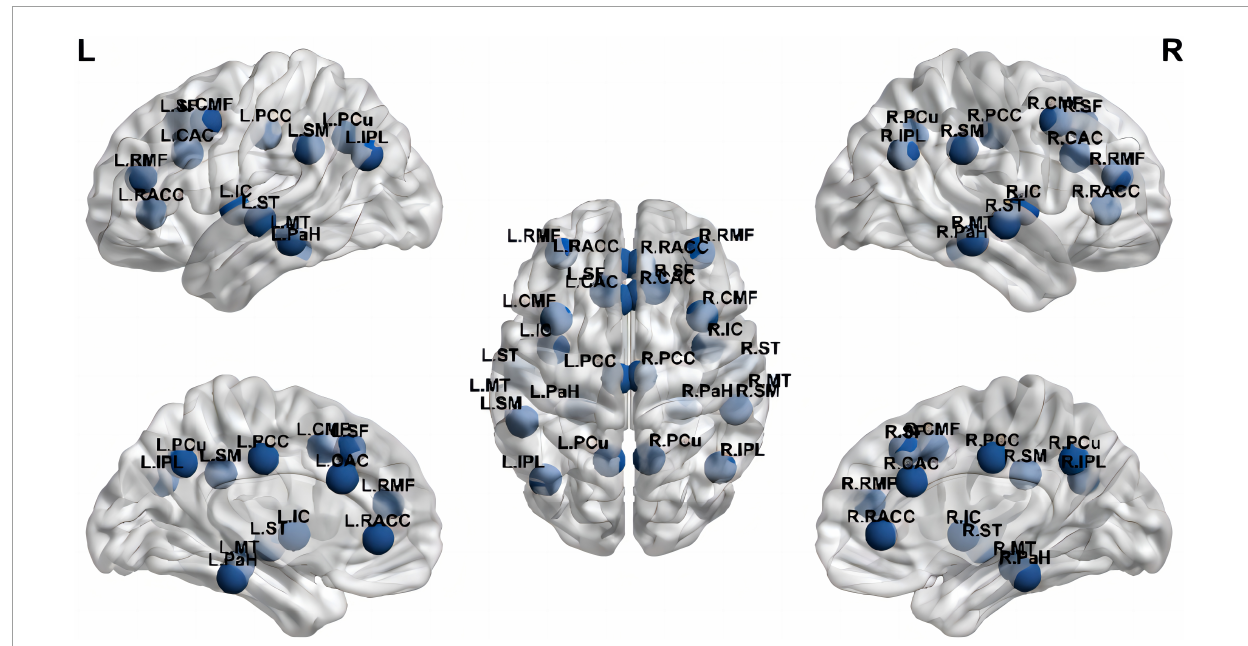
FIGURE1 Nodes at their approximate anatomical location. Labels are the node abbreviations in the text [Generated with BrainNet Viewer (Xia et al., 2013)].